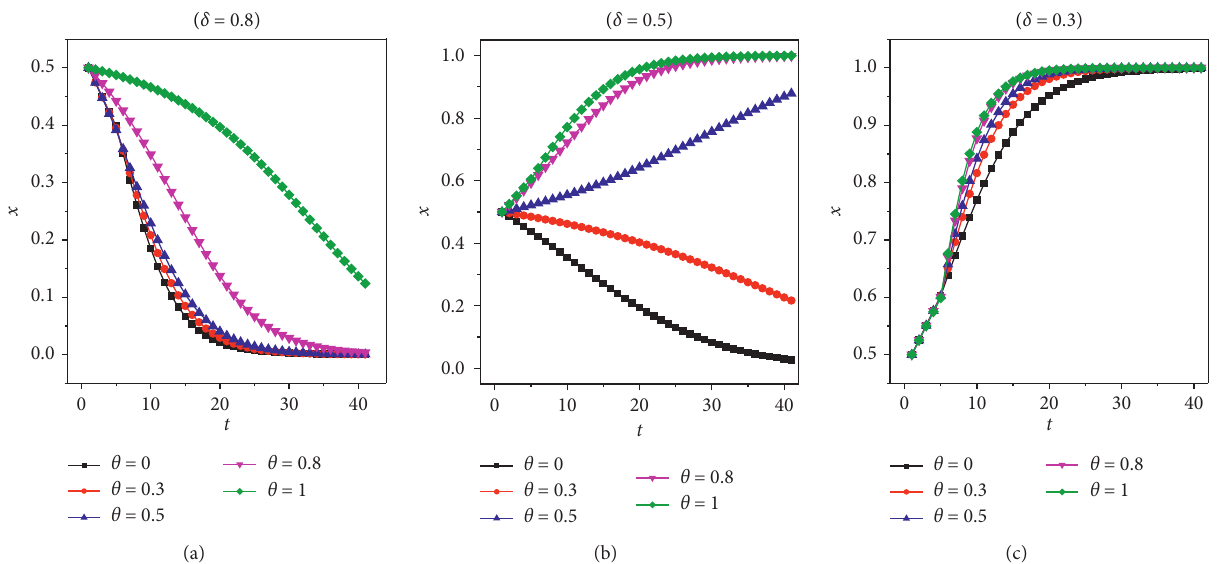
Figure 3: The proportion of innovation-leading firms in the group for different intellectual property protection intensity θ on three levels of the innovation risk δ based on the basic game model.